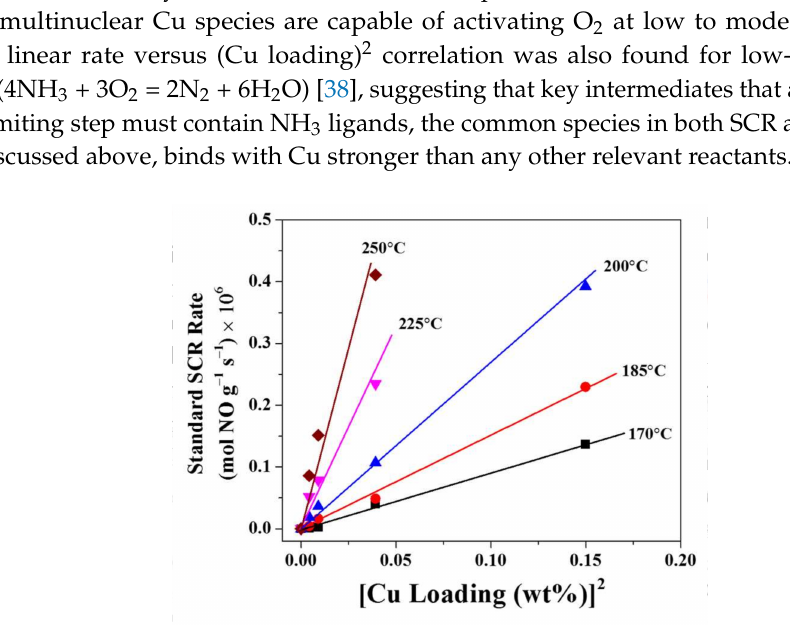
Figure 12. Standard SCR rates (moles NO g − 1 s − 1 ) as a function of the square of the Cu loading for reaction on Cu/SSZ-13 catalysts with low Cu loadings. The reactant feed contains 350 ppm NO, 350 ppm NH 3 , 14% O 2 , 2.5% H 2 O balanced with N 2 at a GHSV of 400,000 h − 1 . Reprinted from J. Catal. , 2014 , 319 , 1–14. Copyright 2014, with permission from